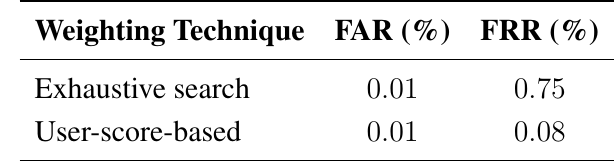
Table 2. Exhaustive search vs. User-score-based